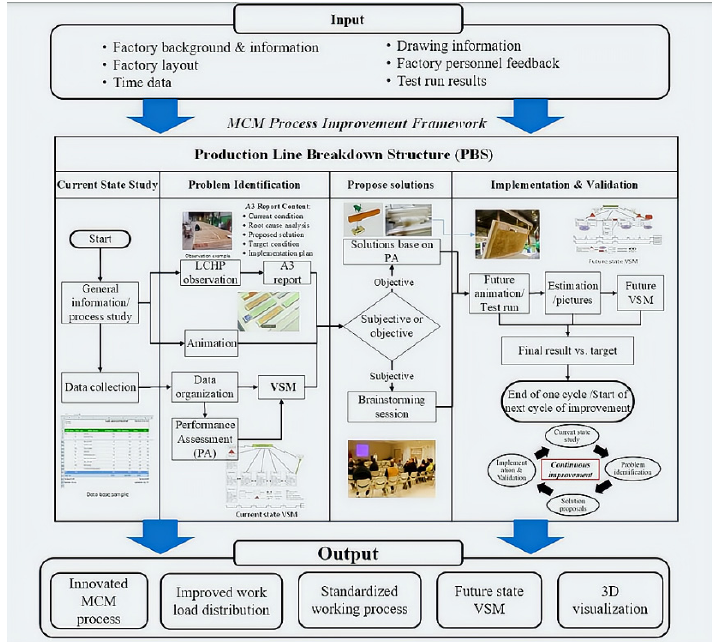
Figure 11. Proposed framework for improving the modular construction process. Reprinted with permission from ref. [103]. Copyright 2020 Copyright American Society of Civil Engineers.